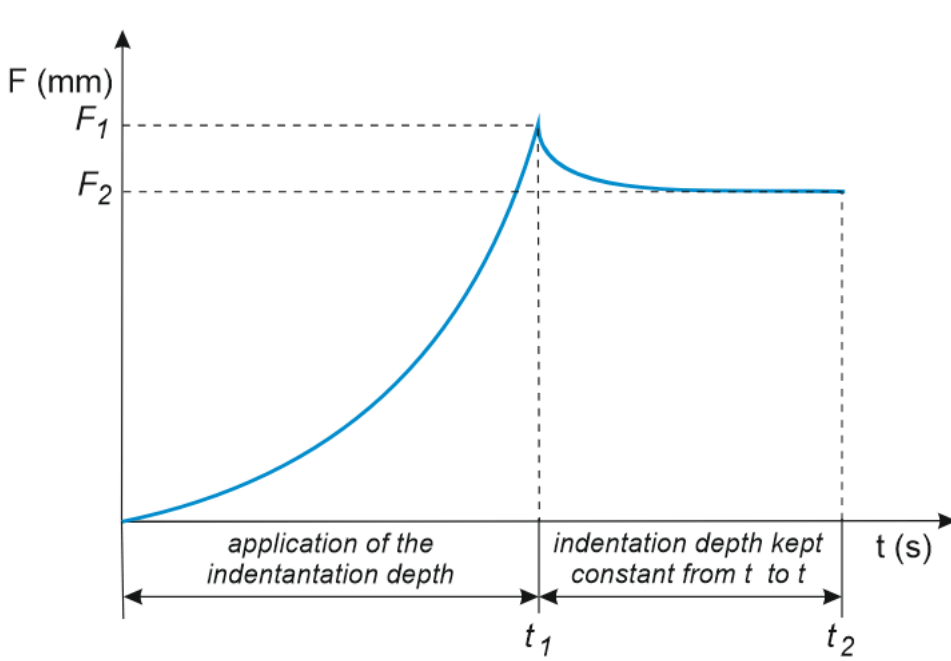
Figure 4. R IT relaxation-parameter determination method.